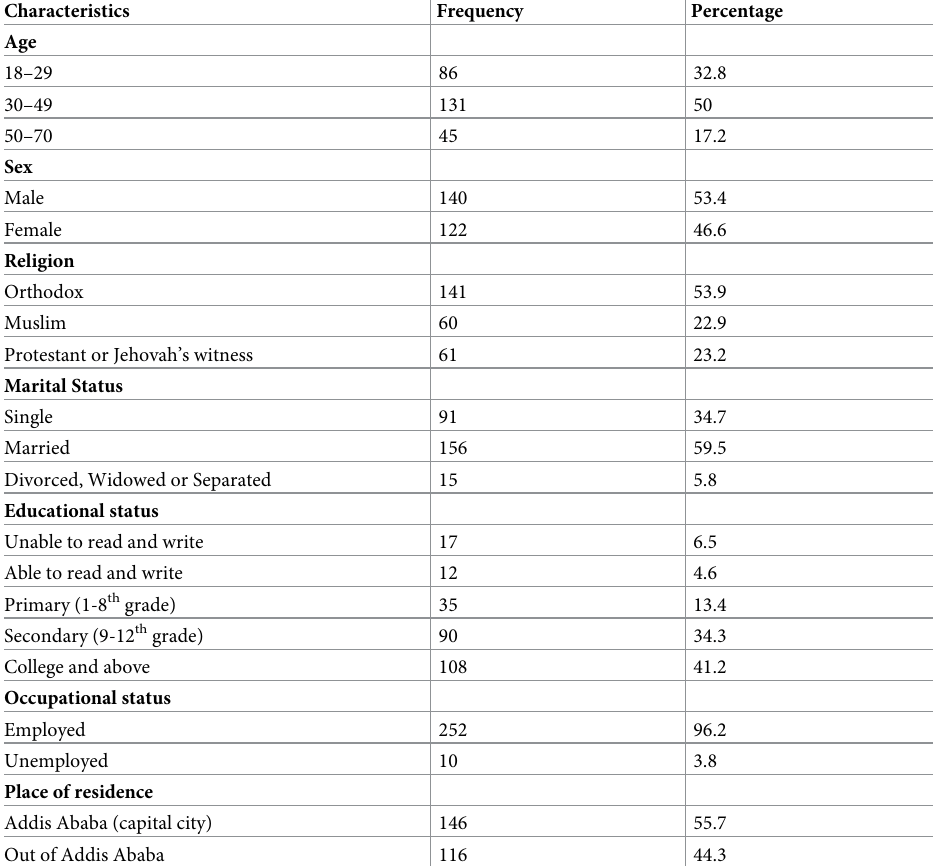
Table 1. Socio-demographic characteristics of